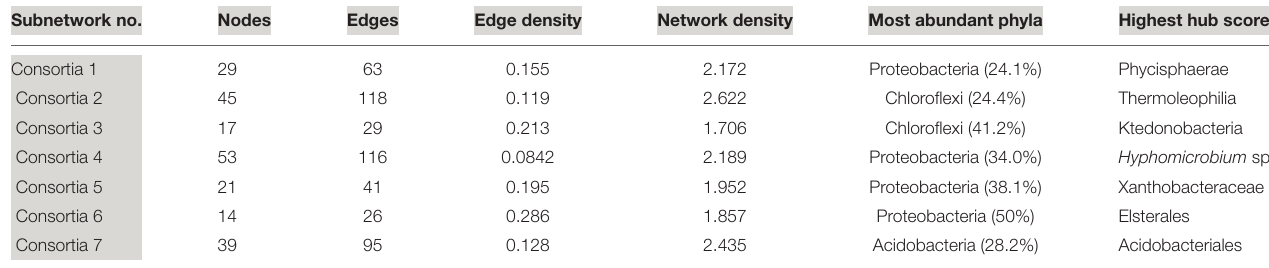
TABLE 2 | Subnetwork statistics and information for geothermal sites. Subnetwork no. Nodes Edges Edge density Network density Most abundant phyla Highest hub